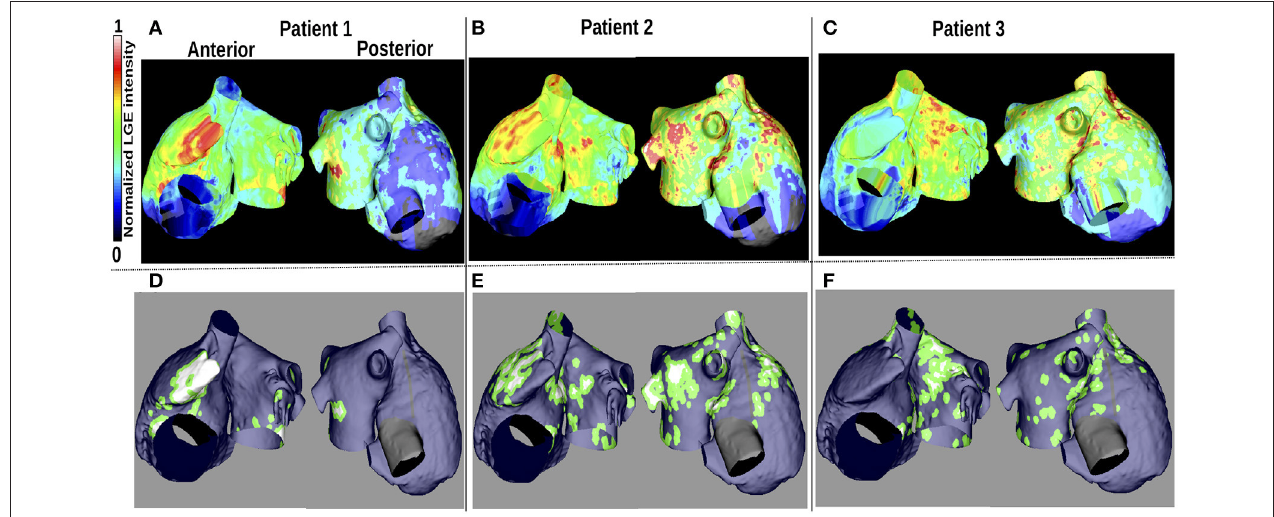
FIGURE 1 | Patient LGE data and fibrosis distribution used for modeling. (A–C) : Normalized LGE intensity. (D–F) : Fibrotic tissue (white), non-fibrotic areas (blue), and the border between them (green) are shown. The inferior vena cava and line of block regions of the model are electrically inactive and displayed in black in (D–F)